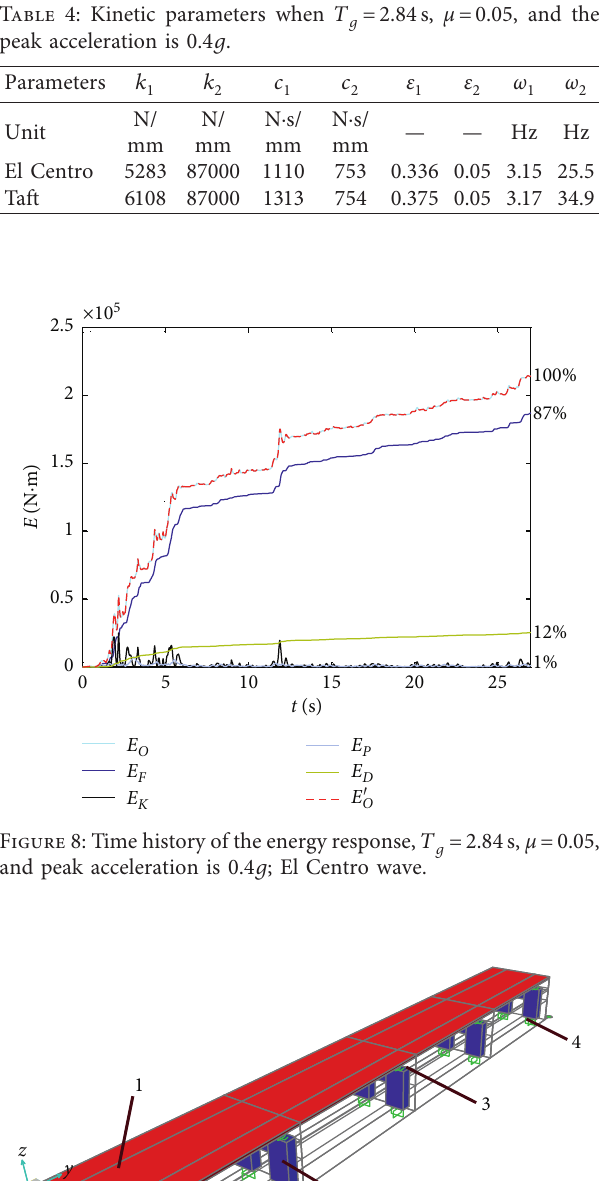
Figure 9: The finite element model of a four-span continuous beam bridge unit with FPBs. (1) Main bridge beam; (2) pier; (3) FPB; and (4) fixed boundary constraints to